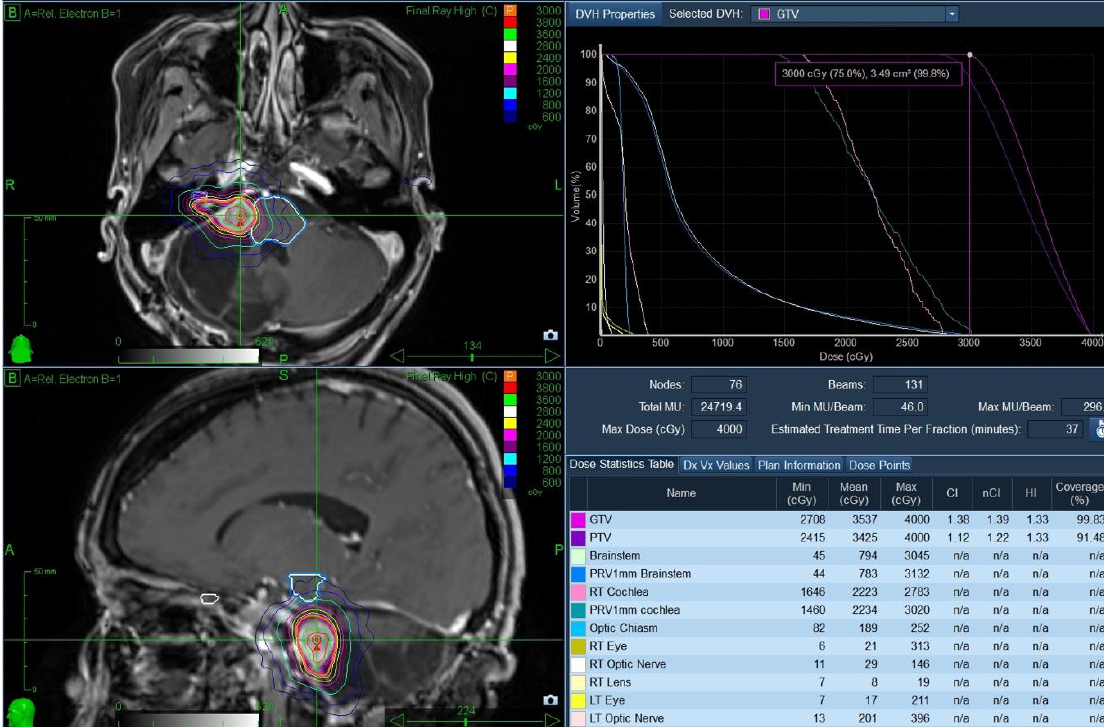
Figure 4. CK SRS treatment plan (January 2016) with the axial and coronal sections, the dose–volume histogram (DVH) and the dose statistics table of the pertinent volumes.